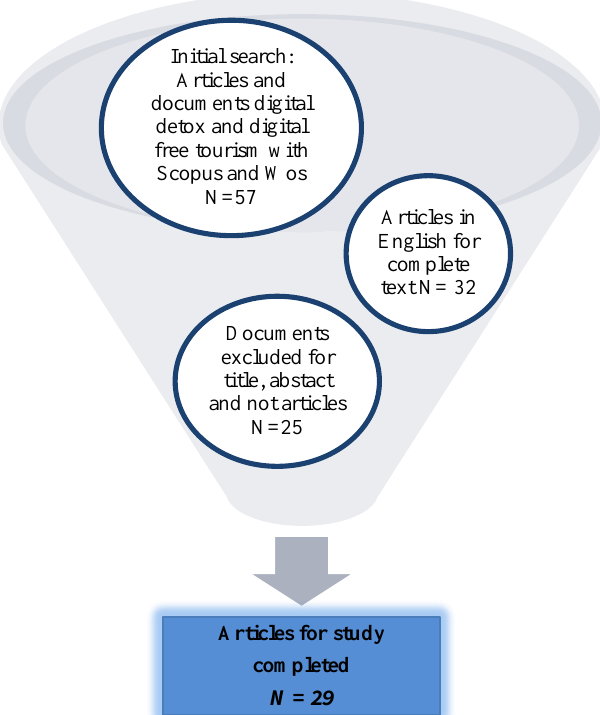
Figure 1. Flowchart research methodology